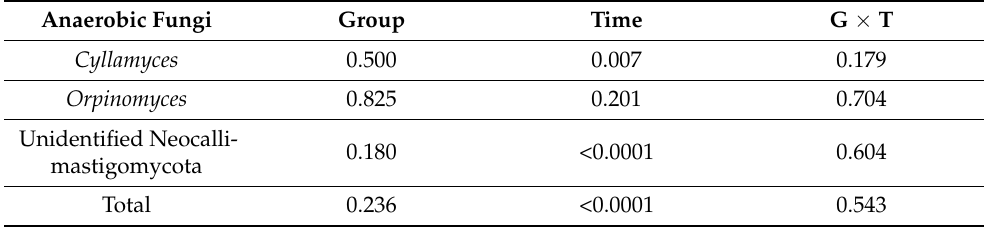
Table 9. p -values associated with the statistical analysis of the relative abundances of anaerobic fungi phyla in the ruminal samples with a linear mixed model.